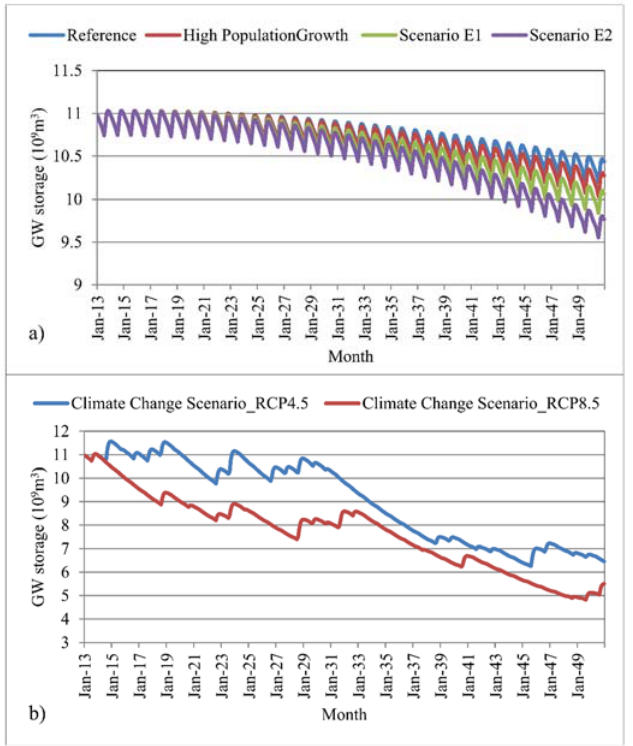
Figure 10. Development of the groundwater storage in billion cubic meters (10 9 m 3 ) for different scenarios ( a ) reference, population growth, socio-economic E1 and E2 and ( b ) climate change RCP4.5 and RCP8.5. Note the differences in the y-axes in both figures.